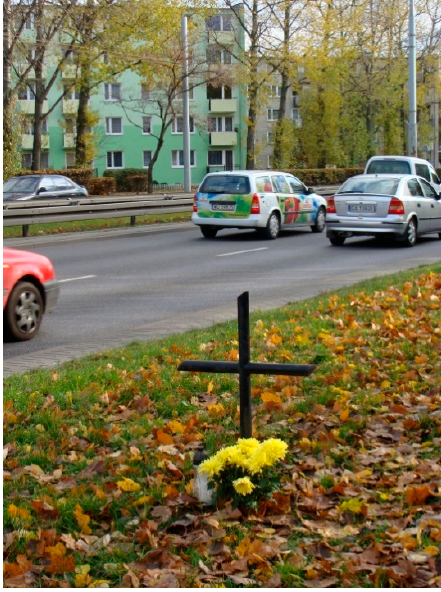
Figure 1. A typical memorial cross in Poland.